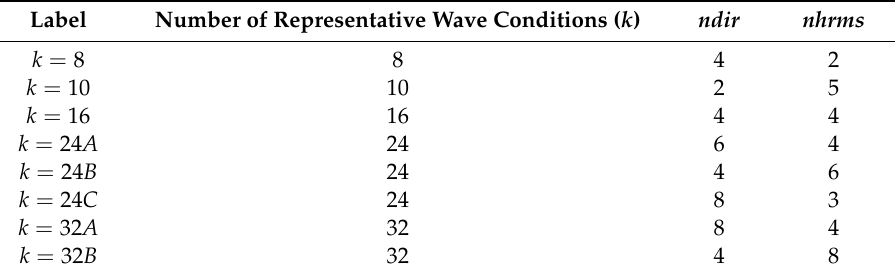
Table 3. Simulated number of wave